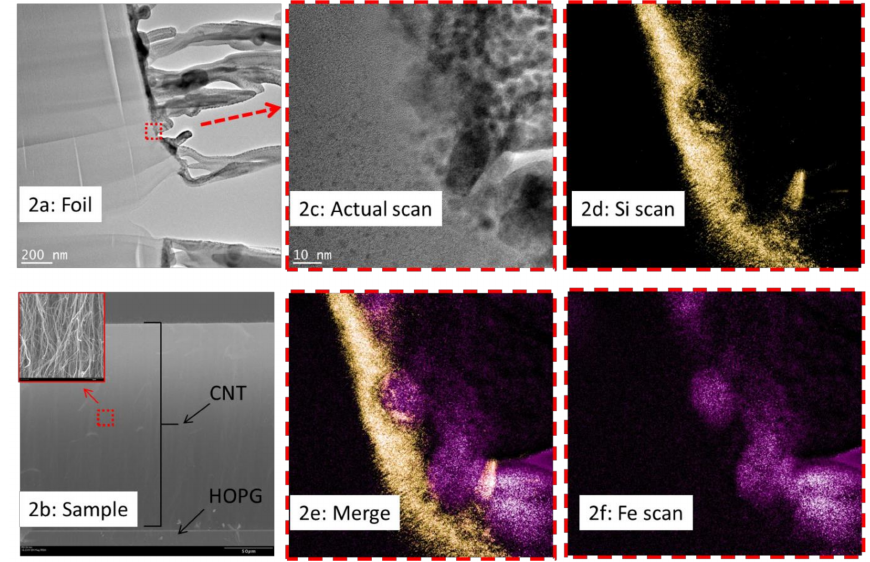
Figure 2. SEM and TEM images of the CNT/HOPG interface, the TEM uses EELS technique to find the oxide layer and the iron catalyst particles. ( a ) SEM image of the lifted cross-section foil of the sample; ( b ) cross-section SEM image of the grown sample, with high magnification image as the small insert to the top left; ( c ) TEM image of the sample taken at the CNT/HOPG interface; ( d ) EELS scan for elemental Si, over the area shown in figure ( c ); ( e ) Merged image from figures ( d , f ); ( f ) EELS scan for elemental Fe, over the area shown in figure ( c